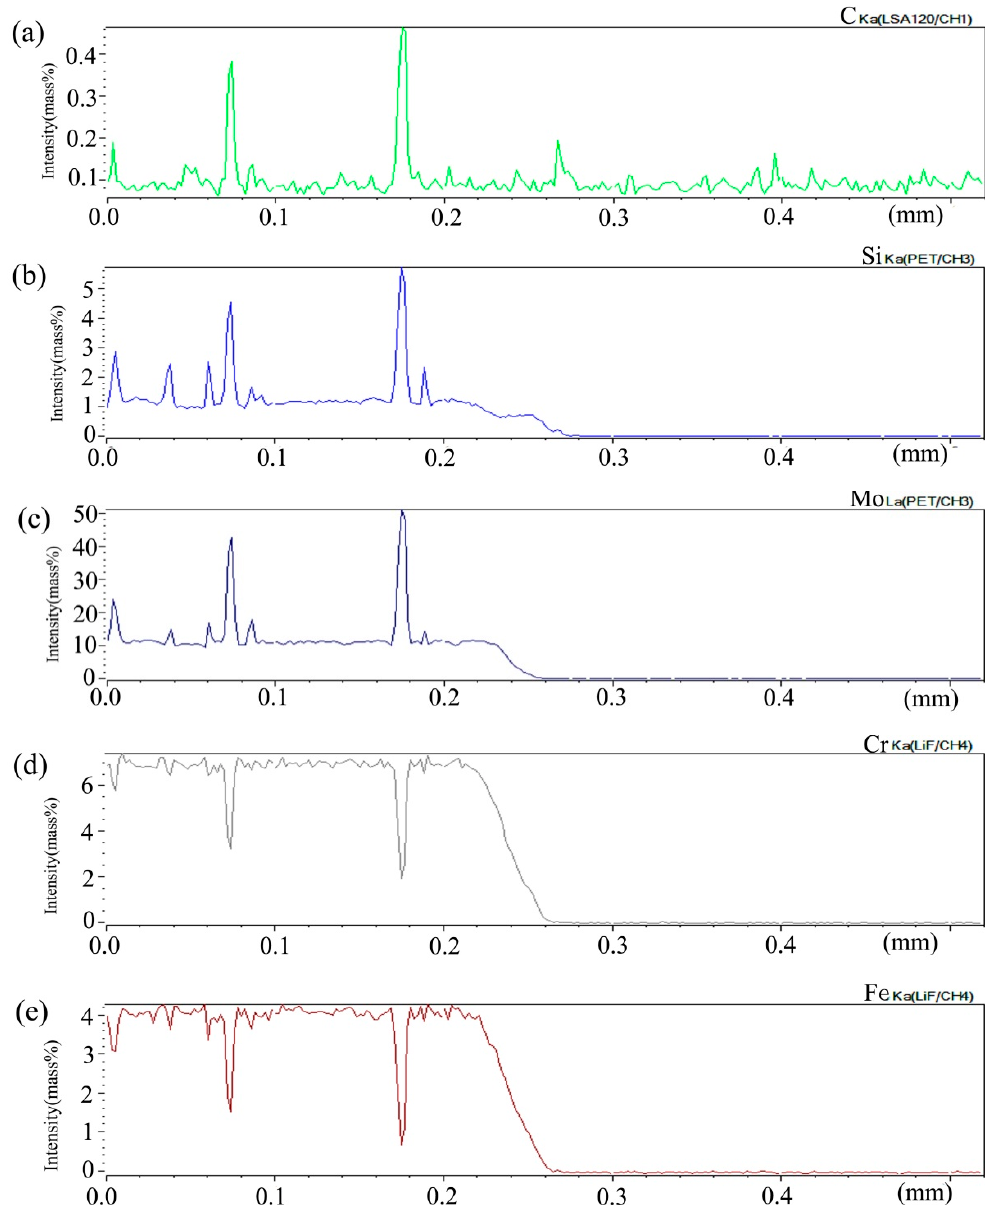
Figure 9. Composition distribution curve of the diffusion couple sample of 2Si alloy and pure nickel after 800 ° C/200 h heat treatment: ( a ) C, ( b ) Si, ( c ) Mo, ( d ) Cr, and ( e ) Fe. (The horizontal coordinate of the figures is the scanning distance and the vertical coordinate is element signal intensity, the zero position is the starting point of scanning).